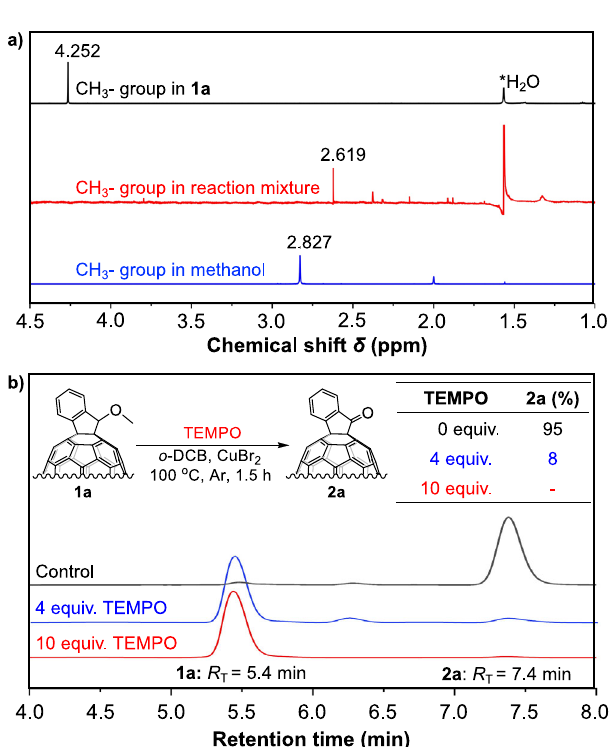
Fig. 4 Mechanistic studies. a 1 H NMR with the H 2 O as internal reference located at up- fi eld for identifying the methyl structure of 1a (black), reaction mixture (red) and methanol (blue). b Experiments in the presence of different amount of TEMPO as radical